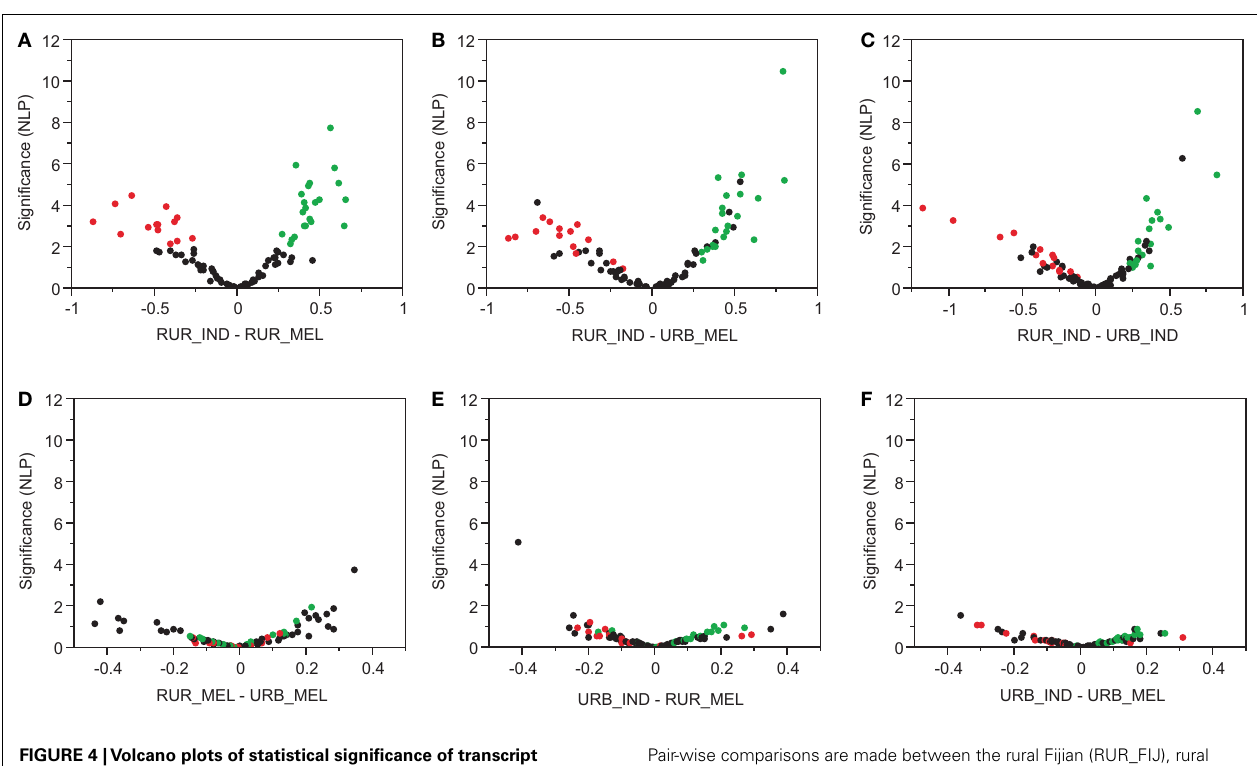
FIGURE 4 |Volcano plots of statistical significance of transcript abundance changes between the different locations and ethnicities. For each gene, significance is indicated by negative log10 p -value is on the y -axis, and the standardized difference in log2 Ct scores on x -axis (positive values imply higher Ct values and hence lower expression).